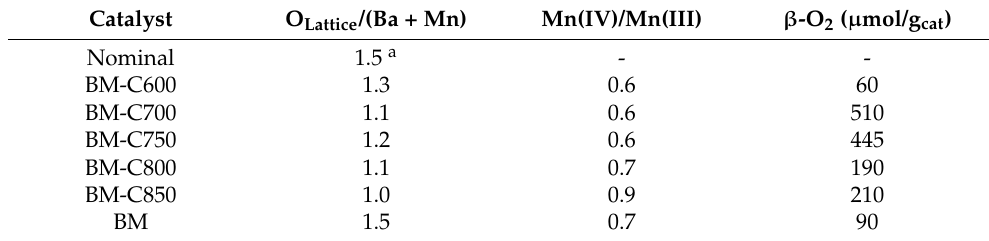
Table 2. XPS ratios and β -O 2 evolved during O 2 -TPD